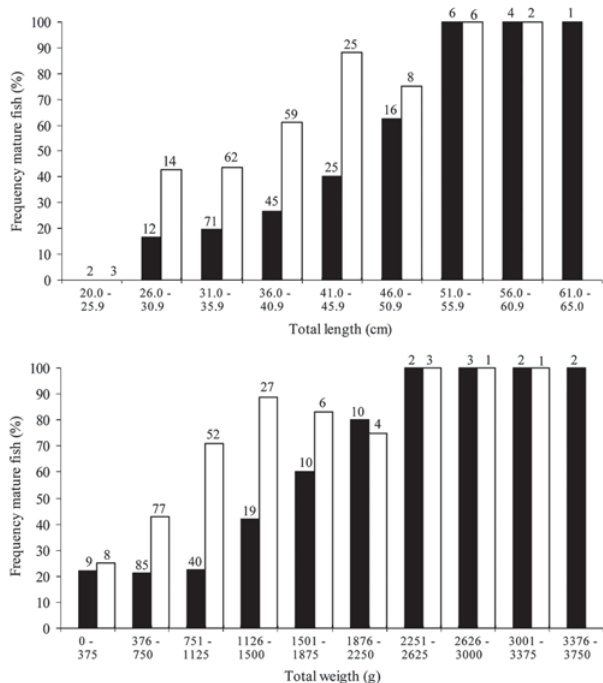
Fig. 4. Percentage of sexually mature males (solid bar) and females (empty bar) of Cichla piquiti collected during the period from December 2004 to November 2005. Sample size is given above